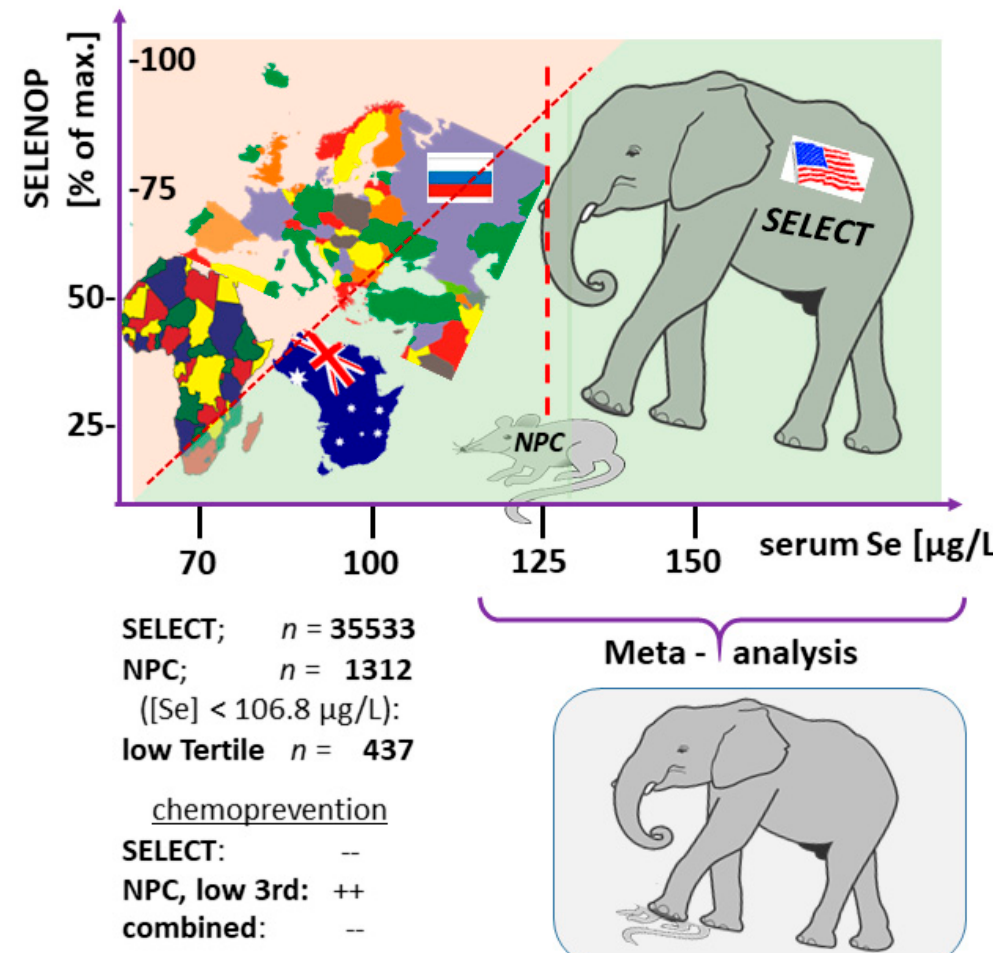
Figure 1. Importance of baseline Se status for the interpretation of RCT results. Dietary intake of Se varies widely in different parts of the world, and large parts of, e.g., the USA, are well supplied. This is in contrast to many other countries. A saturated expression of the Se transporter selenoprotein P (SELENOP, (% of max.)) indicates a sufficiently high Se status and corresponds to serum Se of 120–130 µ g/L (broken line). As only one third of participants in the NPC study were below this threshold and showed positive health benefits from supplemental Se, their contribution to the overall effects is diluted and lost in meta-analyses. Positive health effects of supplemental Se can only be expected if selenoprotein expression is affected, and studies performing substitution versus supplementation need to be distinguished.